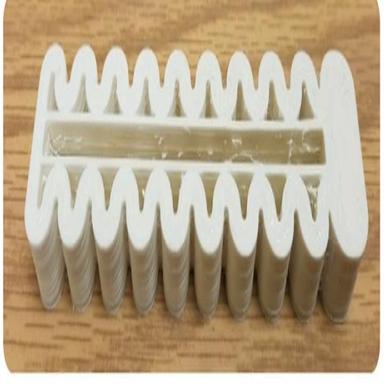
3D printed close dual bellow pneumatic actuator.